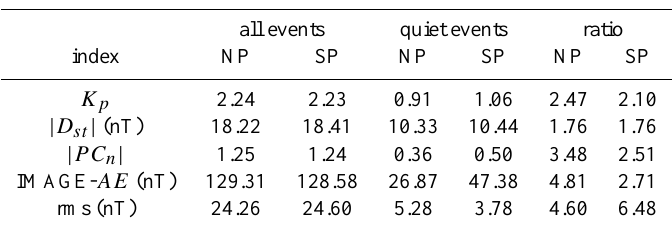
Table 1. Average values of the rms residuals and the K p , PC n , D st , and IMAGE- AE indices for normal and very quiet orbits at the north (NP) and south pole (SP) during the period 08/2000–05/2002.